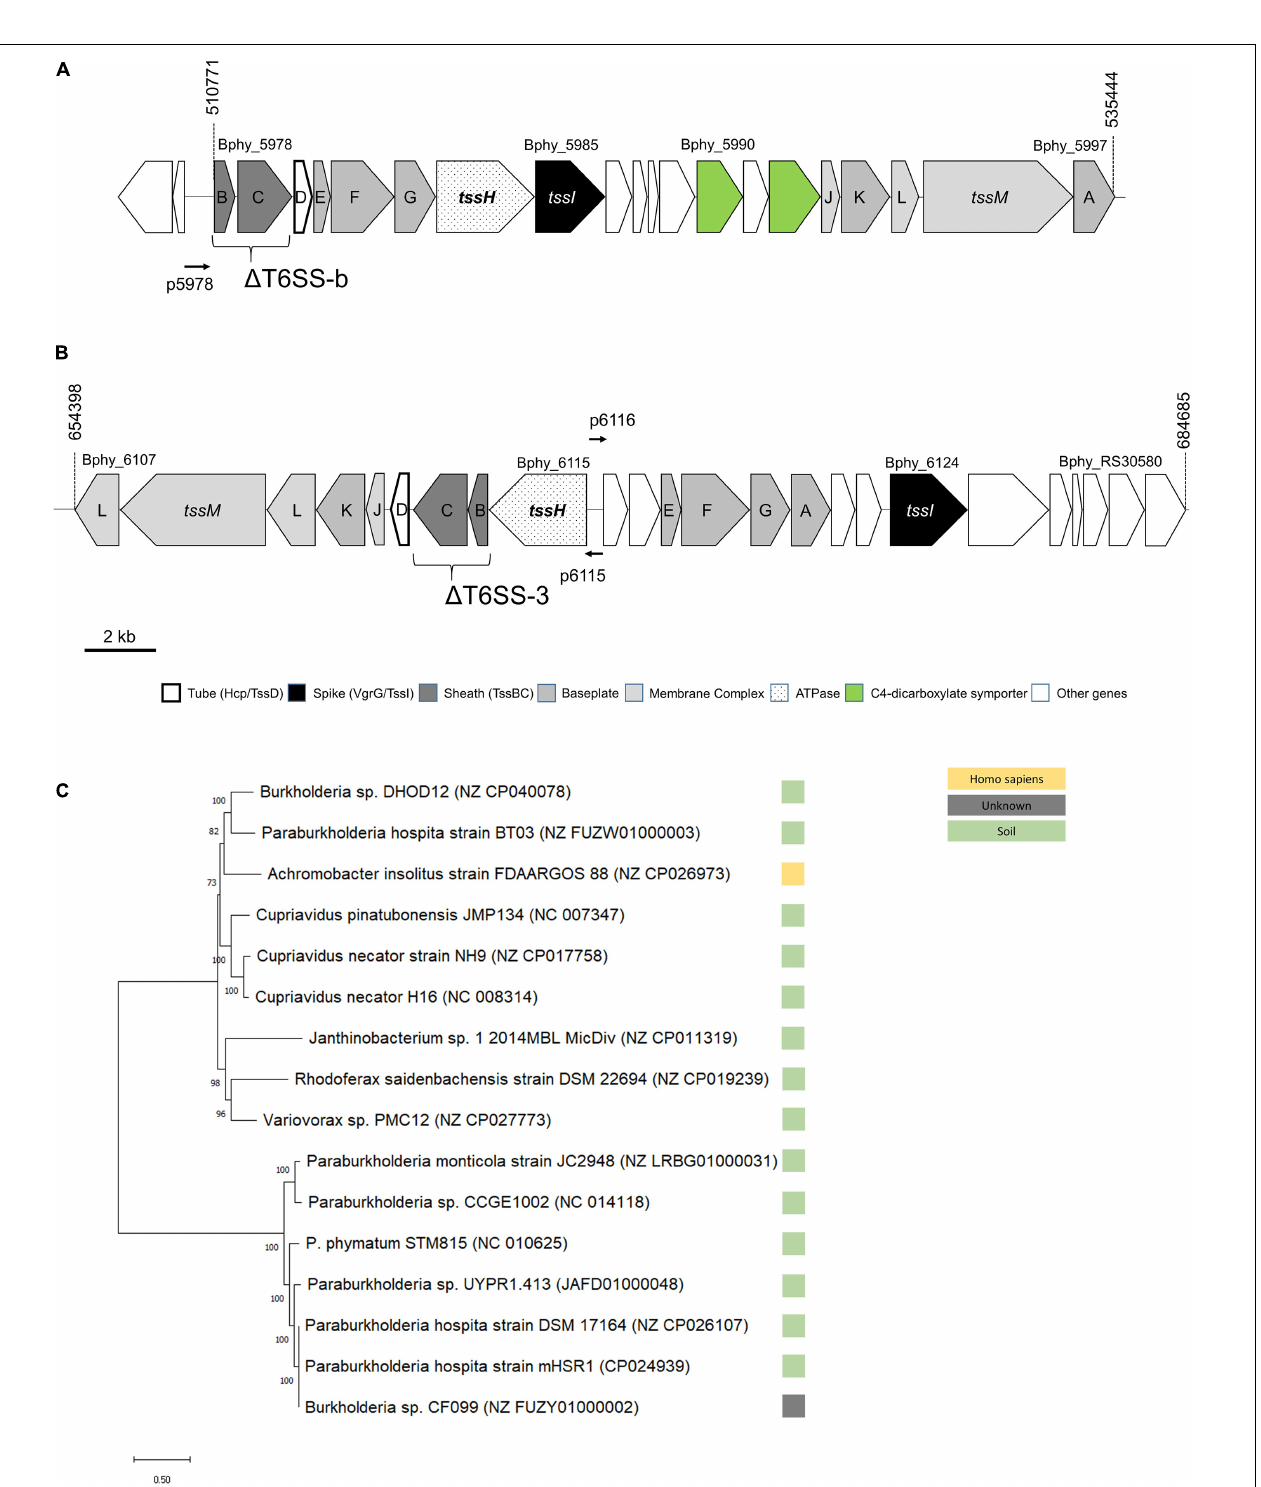
Frontiers in Plant Science |